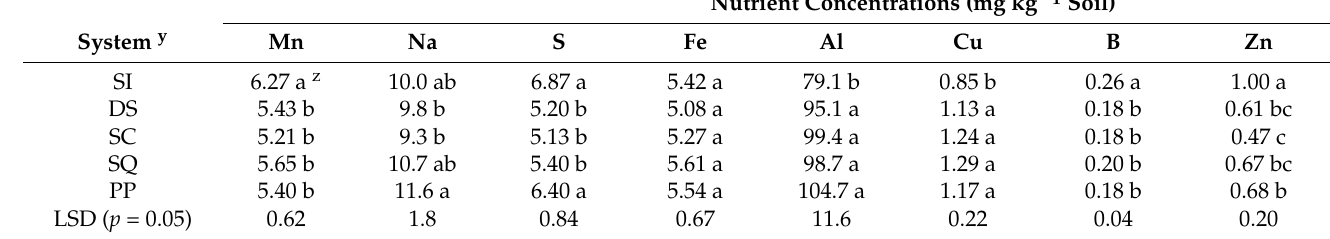
Table 8. Effect of different cropping systems on concentrations of micronutrient elements in soil, including Mn, Na, S, B, Fe, Al, Cu, and Zn from combined data over three cropping seasons (2016– 2018).